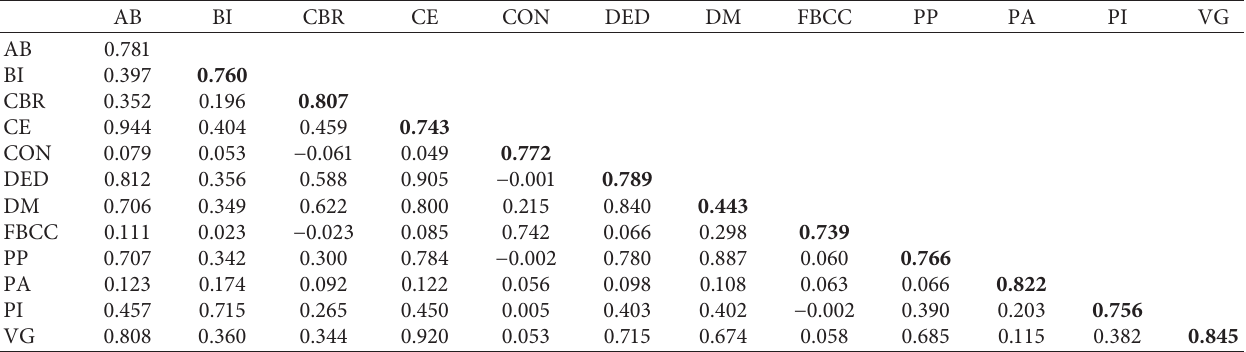
Table 8: Discriminants validity: Fornel–Larcker